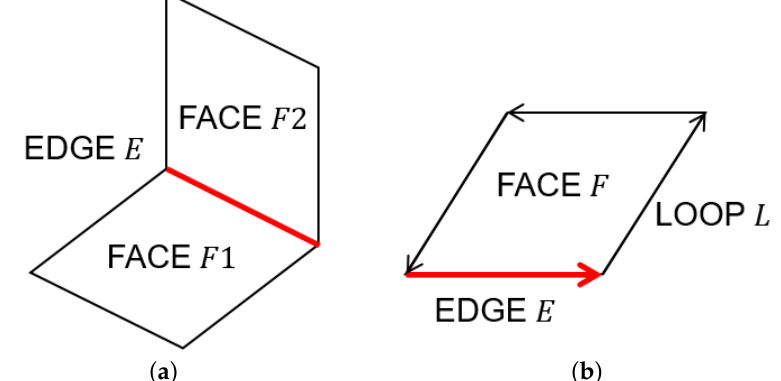
Figure 8. Examples of Topological Tests. ( a ) FACEs F 1 and F 2 are adjacent (through EDGE E ), ( b ) FACE F contains EDGE E .